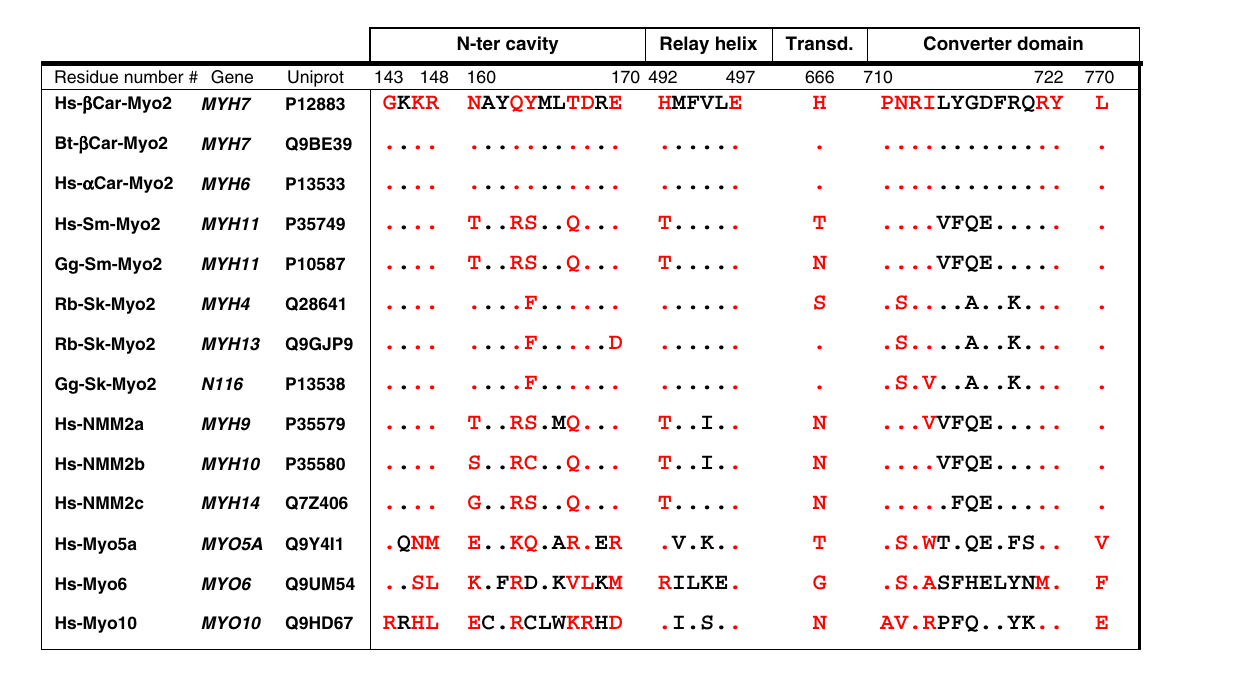
N-ter cavity Relay helix